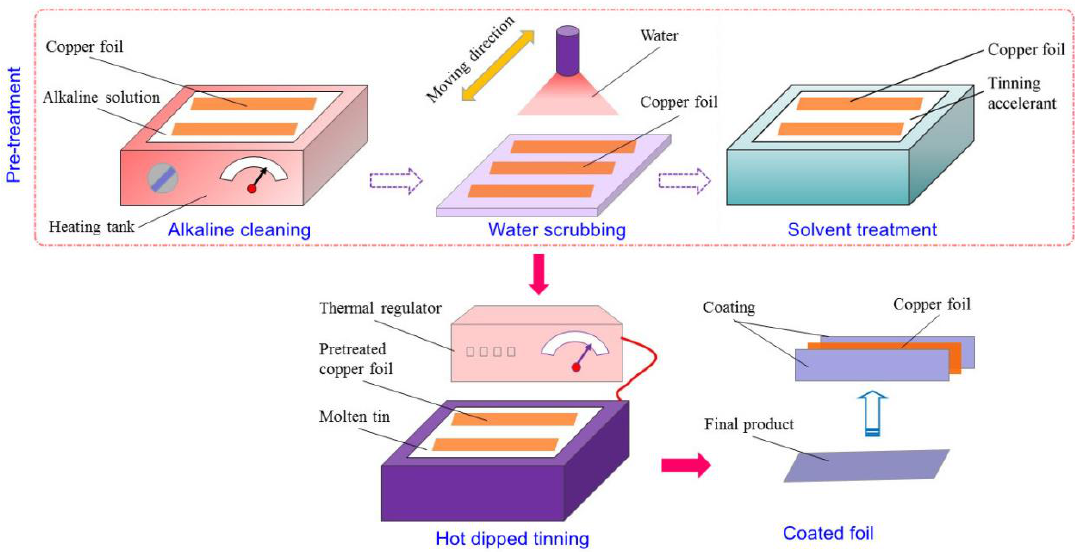
Figure 1. Process procedures of hot-dipped tinning. Table 1. Dimensions and mechanical properties of copper foils used in experiments.